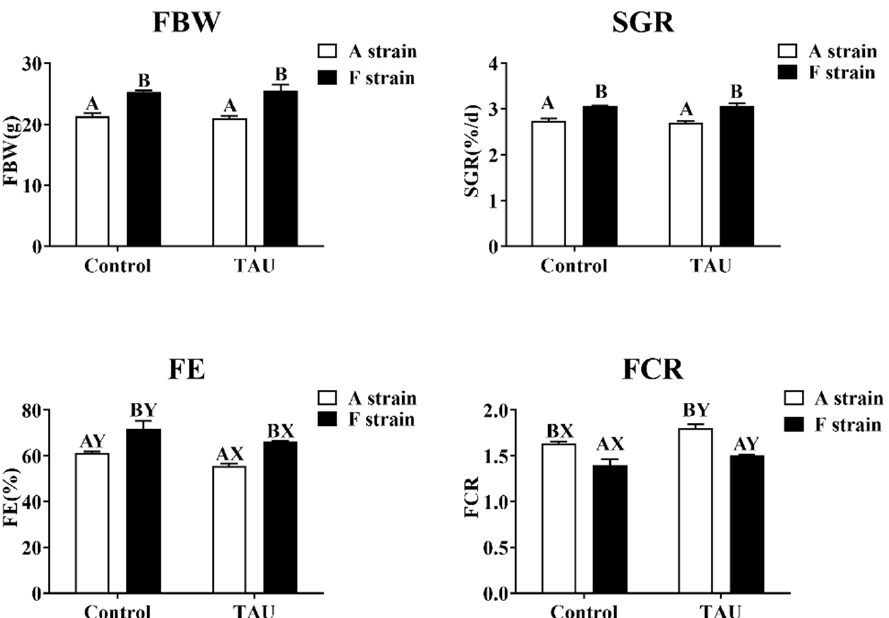
Figure 2. Specific growth rate and feed efficiency of two gibel carp strains fed the control diet and diet supplemented with taurine. Control: control diet, white bars; TAU: diet supplemented with taurine, black bars. FBW: final body weight; SGR: specific growth rate (%/d) = 100 × [ln (final weight) − ln (initial weight)]/day; FE: feeding efficiency (%) = (100 × body weight gain)/dry feed intake; FCR: feed conversion ratio = (100 × dry feed intake)/body weight gain. Bars with different uppercase letters (A, B) represent significant differences between the A and F strains ( p < 0.05). Bars with different upper-case letters (X, Y) represent significant differences between the control diet group and the taurine diet group ( p < 0.05).